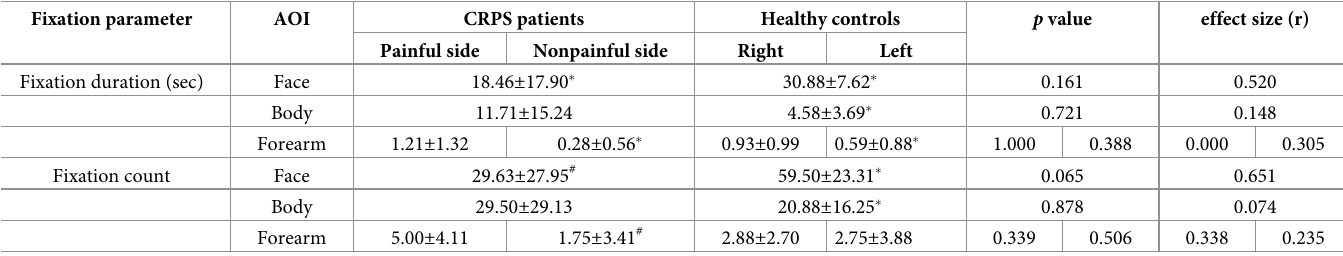
Table 2. Eye movement data of video clip